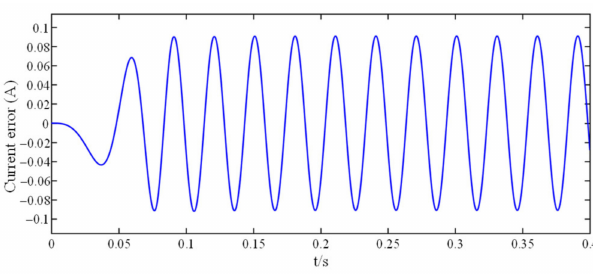
Figure 20. The current error graphs when R = 0.102 Ω .